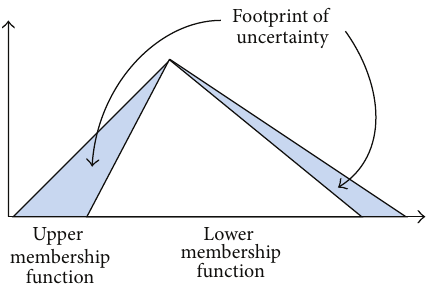
Figure 13: type-2 fuzzy